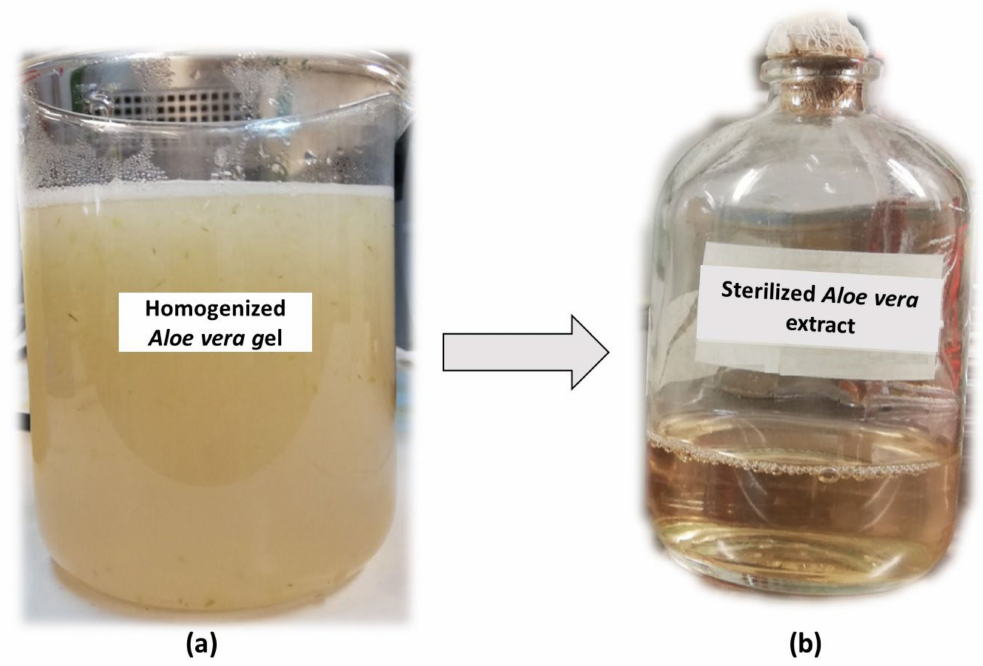
Figure 1. Aloe vera used in this work: ( a ) homogenized Aloe vera gel, ( b ) filtered and sterilized Aloe vera